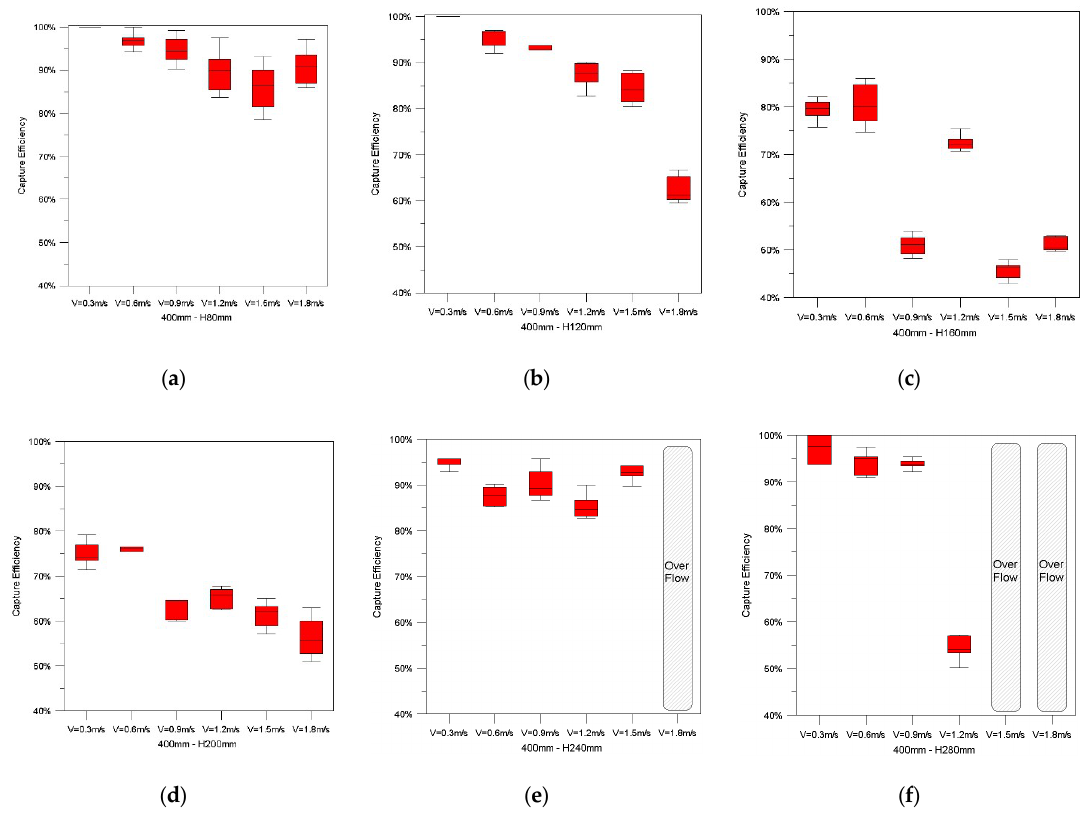
Figure 7. Capture efficiency of the driftwood capture trellis according to depth: ( a ) H = 80 mm; ( b ) H = 120 mm; ( c ) H = 160 mm; ( d ) H = 200 mm; ( e ) H = 240 mm; ( f ) H = 280 mm. Table 7. Capture e ffi ciency of the driftwood capture trellis by experimental